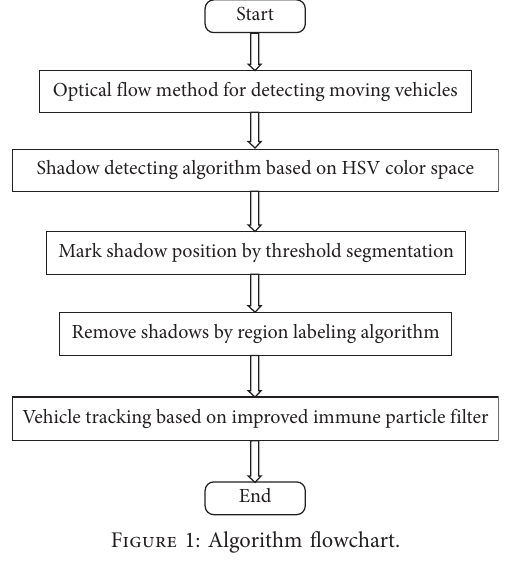
Figure 1: Algorithm